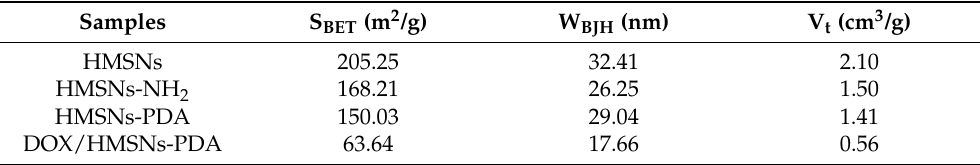
Table 2. BET surface area (S BET (m 2 /g)), pore diameter (W BJH (nm)), and pore volume (Vt (cm 3 /g)) values of